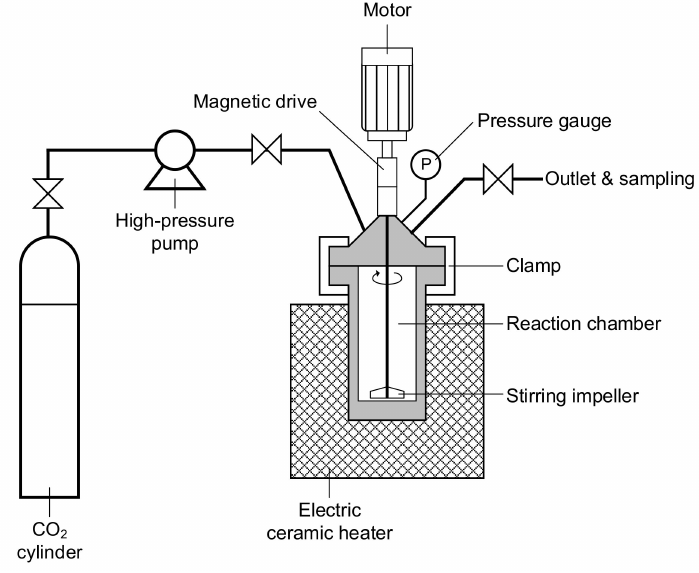
Figure 1. Schematic of the experimental